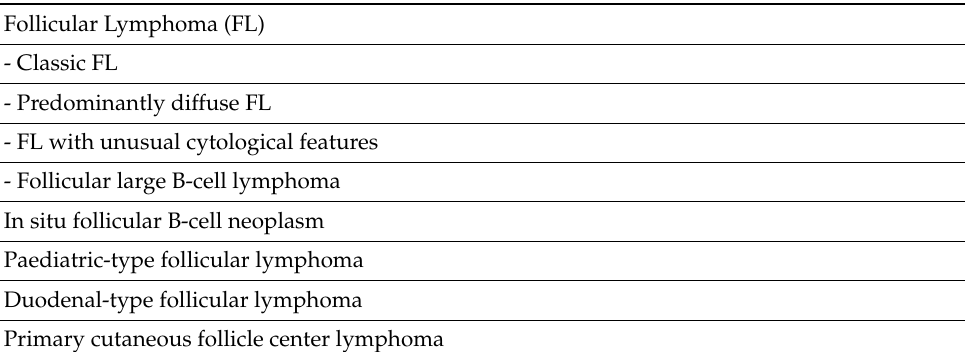
Table 1. Overview of FL subtypes as described in the